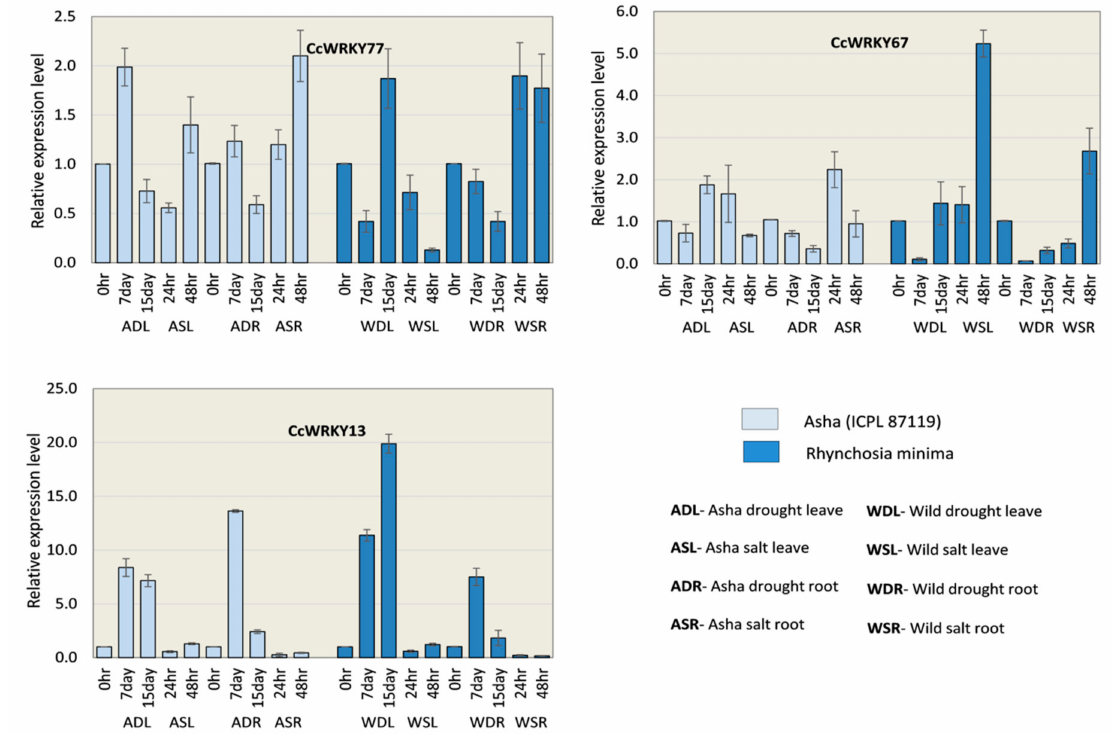
Figure 8. Expression profiling of seven WRKY genes in various tissues of pigeonpea grown under drought and high salinity stress. The expression level of these CcWRKY genes was investigated in leave and root tissues of two di ff erent genotypes Asha (ICPL 87119) and Rhynchosia minima (Wild) in response to drought and salinity treatments. All experiments were conducted with three biological